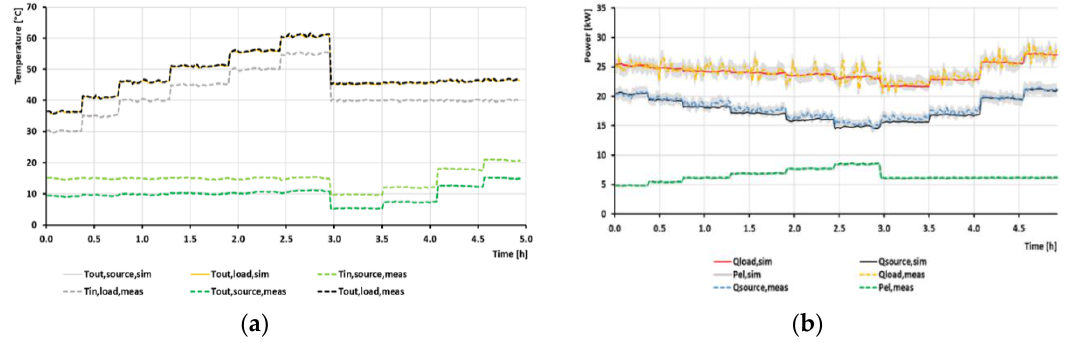
Figure 5. Results of the WSHP model validation: ( a ) measured vs. simulated inlet and outlet temperatures and ( b ) electrical and thermal powers.